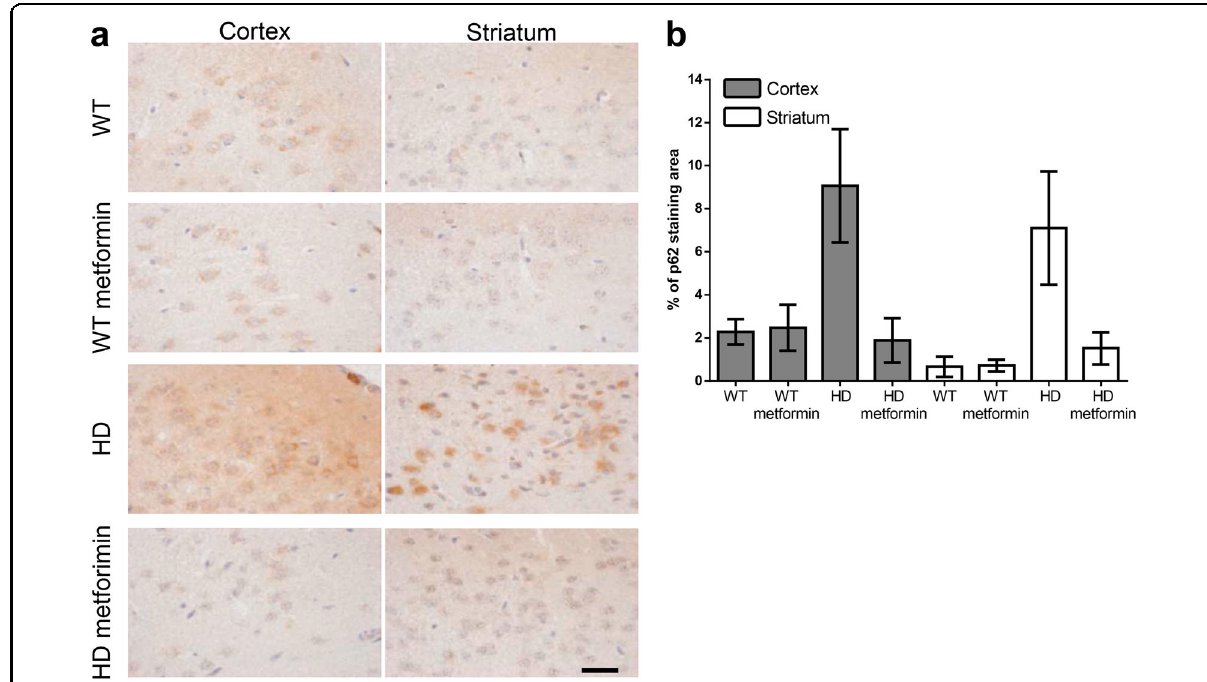
Fig. 5 Levels of autophagy receptor p62 in brain tissue of 6-month-old control and zQ175 mice treated or not with metformin. a Immunohistochemical (IHC) staining illustrates the expression levels of p62 in the cortex and striatum of zQ175 (Huntington disease (HD)) mice and their corresponding controls (wild type (WT)). Representative images of each condition are shown (bars: 50 µm). b Semiquantitative analysis of IHC staining using the ImageJ software. Samples from four independent mice from the WT and nontreated HD groups and 5 mice from the treated HD group were analyzed, which generated 13 cortex and 8 striatum pictures from untreated wild-type (WT), 12 cortex and 7 striatum pictures from treated wild-type (WT metformin), 14 cortex and 7 striatum pictures from untreated zQ175 (HD), and 14 cortex and 13 striatum pictures from HD- treated (HD metformin) mice. The analyzed area in each picture was 90,488 μ m 2 . HD mice showed higher levels of p62 than WT mice ( p < 0.001), and treatment with metformin reduced the levels of p62 ( p < 0.001) to values similar to those in WT mice. Values are the mean, and bars indicate the con fi dence interval (95%